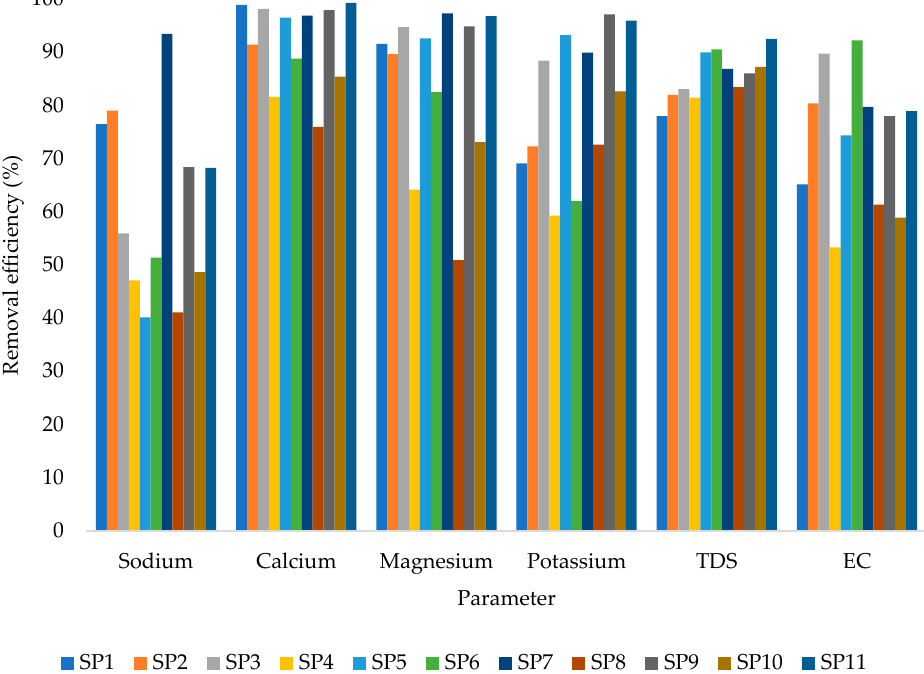
Figure 3. Removal efficiency from 0.5 m (V f : 0.0035 L/s; pH: 6.4–12.5; T: 22.6–24.4 °C; n = 8). SP1–SP11 are the sampling points (one to eleven)